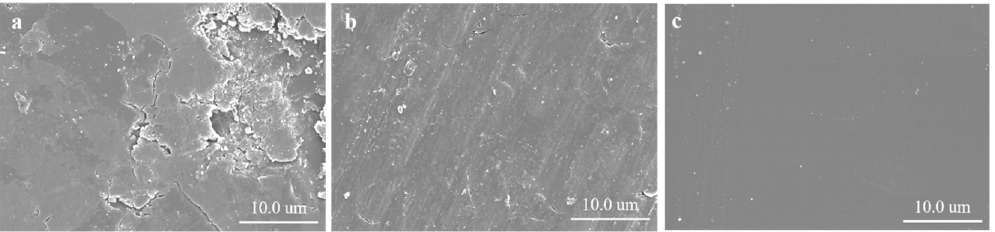
Figure 6. SEM images of the worn surfaces of neat BMI ( a ), 0.6 wt% G/BMI ( b ), and 0.6 wt% G/COFs/BMI ( c ). G/COFs/BMI ( c